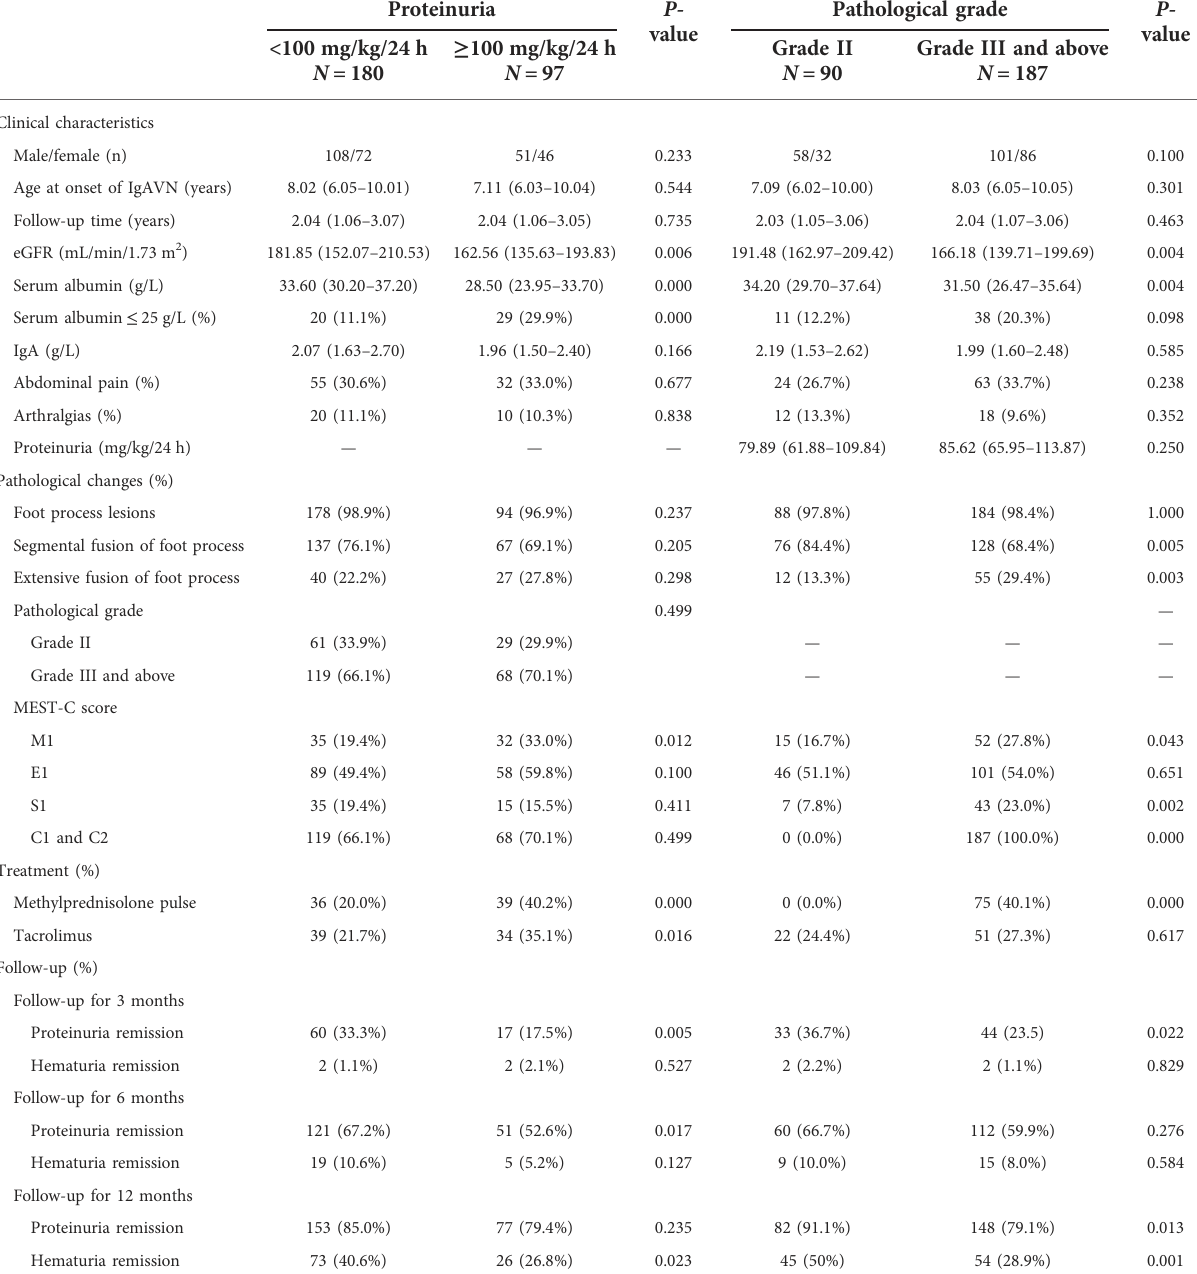
TABLE 3 Effects of proteinuria and pathological grade on the severity of IgAV combined with nephrotic-range proteinuria. Proteinuria P -